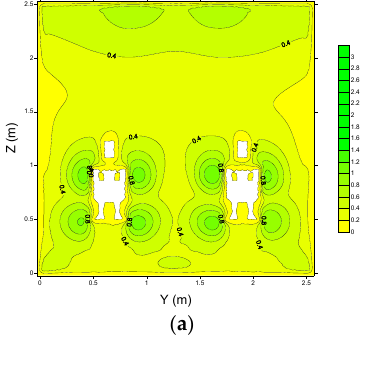
Figure 5. Three-dimensional arrangement for 6 occupants ( a ), X = 1.791 m (red plan) and Y = 0.63099 m (green plan) and 12 occupants ( b ), X = 1.791 m and Y = 0.4423